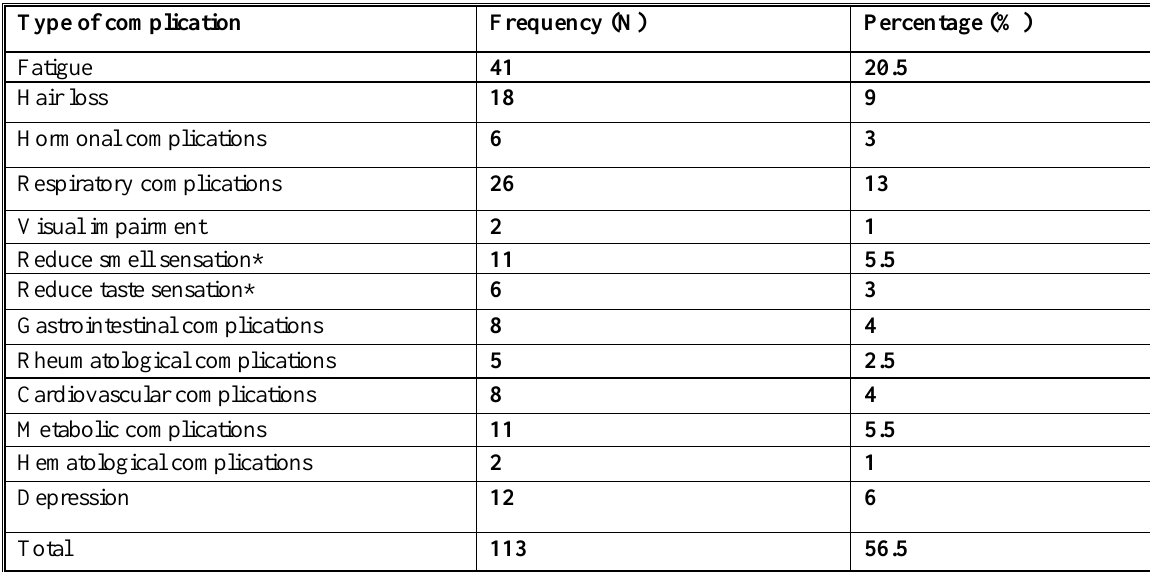
Table4. Complications of the patients